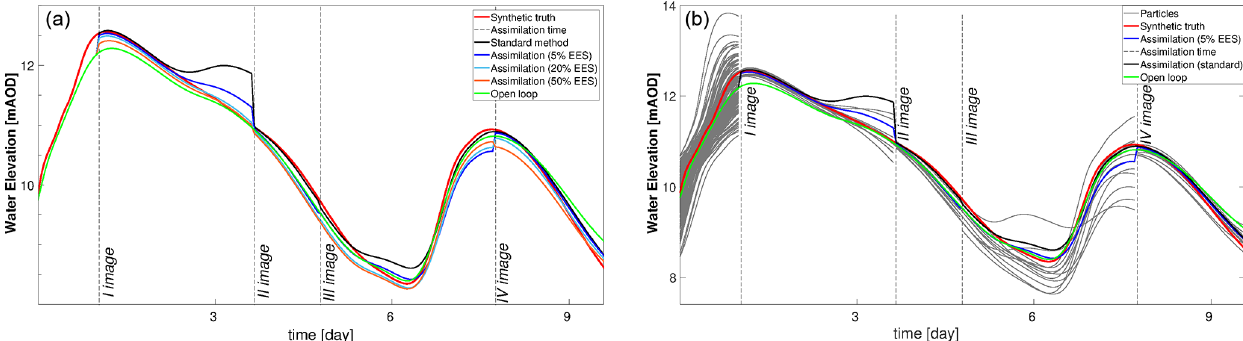
Figure 10. Water level time series at Saxons Lode. (a) Assimilation runs with an EES of 5% (blue), 20% (cyan), and 50% (orange) as well as OL (green) and standard assimilation (black). (b) Particles carrying significant weight after the assimilation at 5% EES (gray). Dashed lines correspond to the assimilation times.